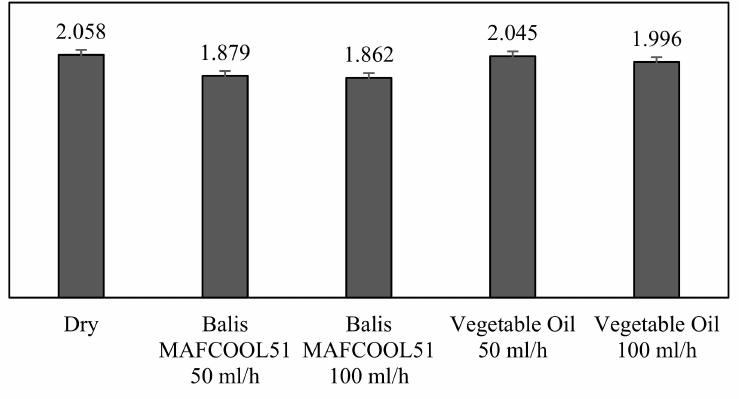
Figure 10. Average surface roughness of the workpiece in each group of machining tests; units in µ